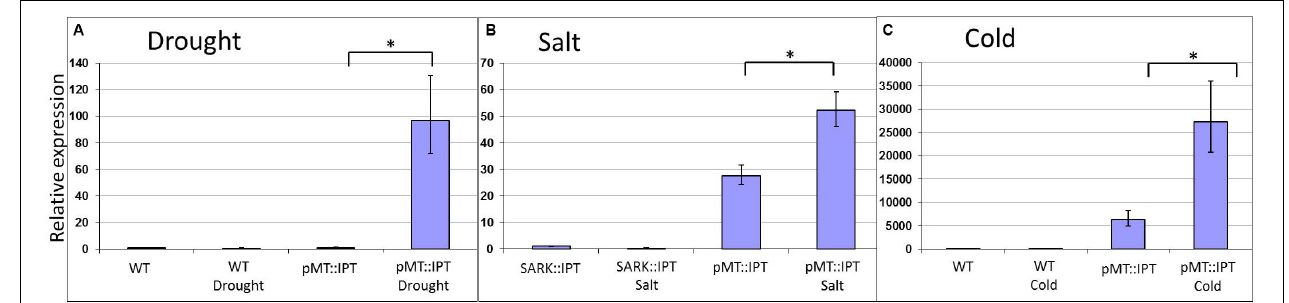
FIGURE 1 | Relative expression of IPT in transgenic pMT:IPT and WT in plants under drought (A) , salinity (B) , and cold (C) stress conditions as determined by real-time PCR (RT-PCR). Tobacco plants were grown under optimal conditions for 3 weeks, then they were subjected to cold stress of 4 ◦ C for a week. For salinity stress, plants were watered with NaCl solution (100 and then 200 mM) for three more weeks. For the drought-stress treatment, watering of mature tobacco plants was withheld for 3 weeks. Leaf samples were collected simultaneously from all plants (in three independent replicates). Gene expression was determined by RT-PCR. Gene expression in the WT plants under control conditions was used as a reference. Asterisk refers to statistically significant difference between treatments ( p < 0.05). Values correspond to means ± SE of three independent experiments.